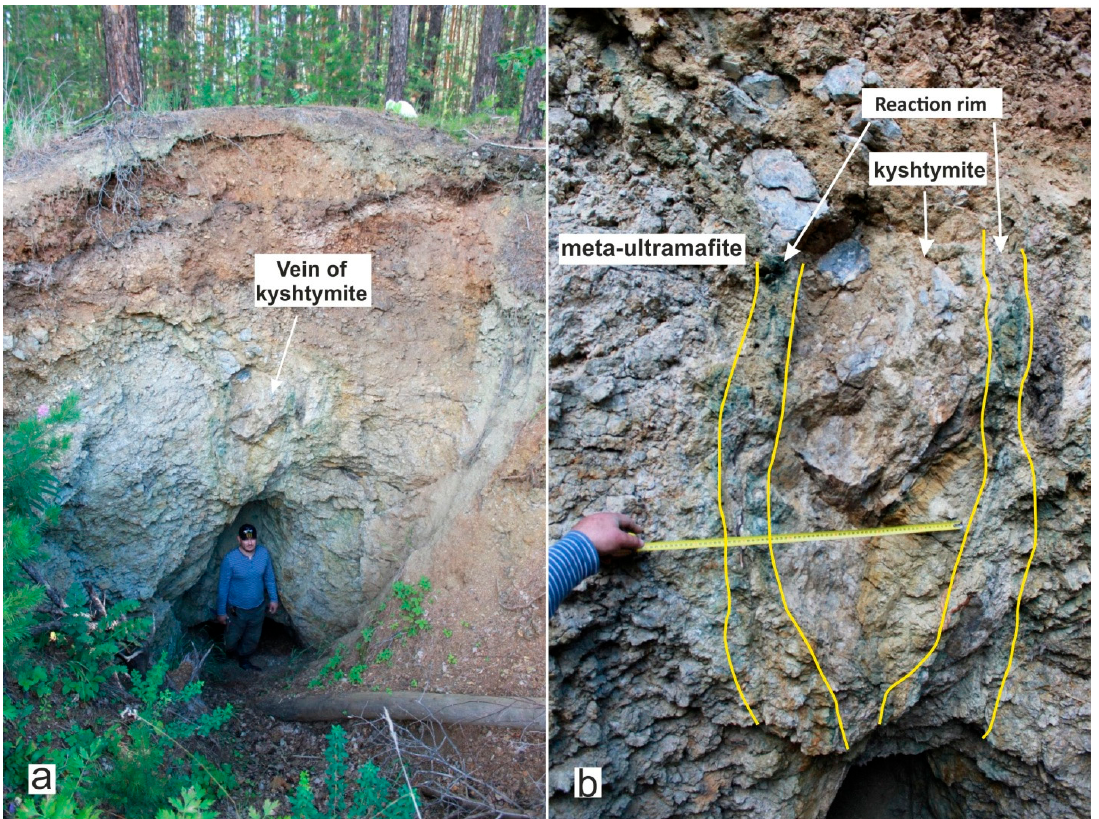
Figure 2. Vein of corundum-blue sapphire anorthosites-kyshtymites: ( a ) the kyshtymite outcrop, thickness is about 3 m; and ( b ) A kyshtymite vein is at a contact with the meta-ultramafic host rock, their contact showed by a green-colored reaction rim consisting of chrysotile-asbestos.